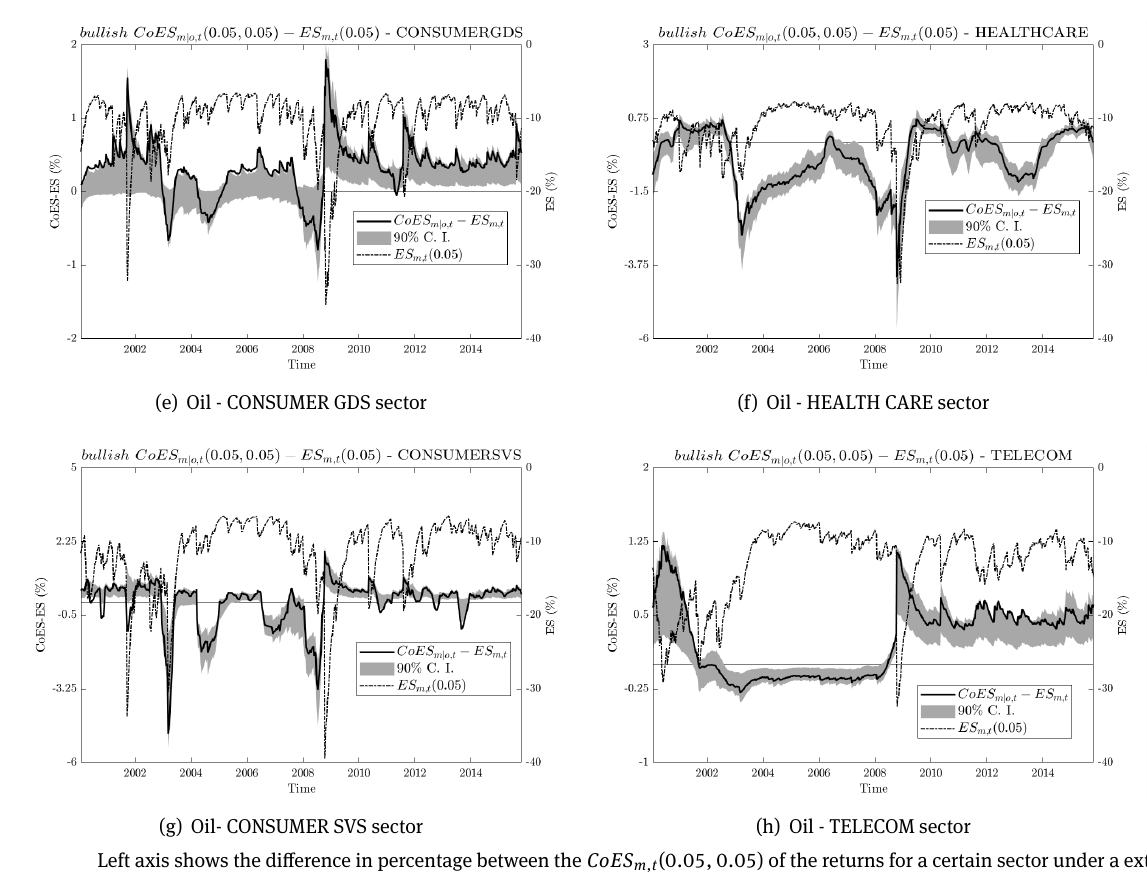
Figure 20b: CoES m | o , t (0.05, 0.05) for a certain sector given a bullish scenario for oil